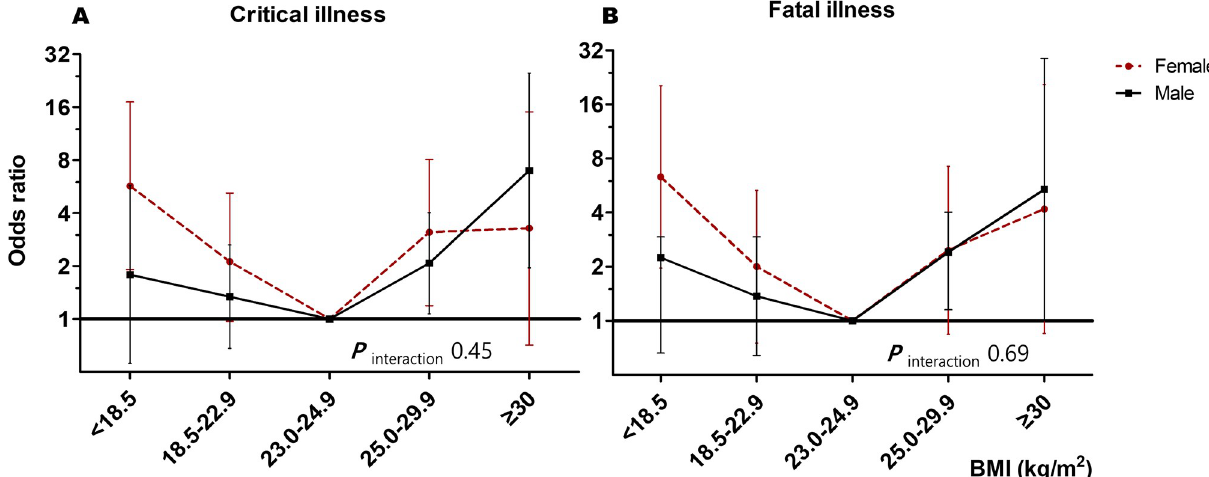
Fig 2. Odds ratios for critical and fatal illness of male and female according to body mass index (A) critical illness, (B) fatal illness Odds ratios were adjusted for age and five comorbidities (diabetes mellitus, hypertension, chronic kidney disease, cancer, and dementia).